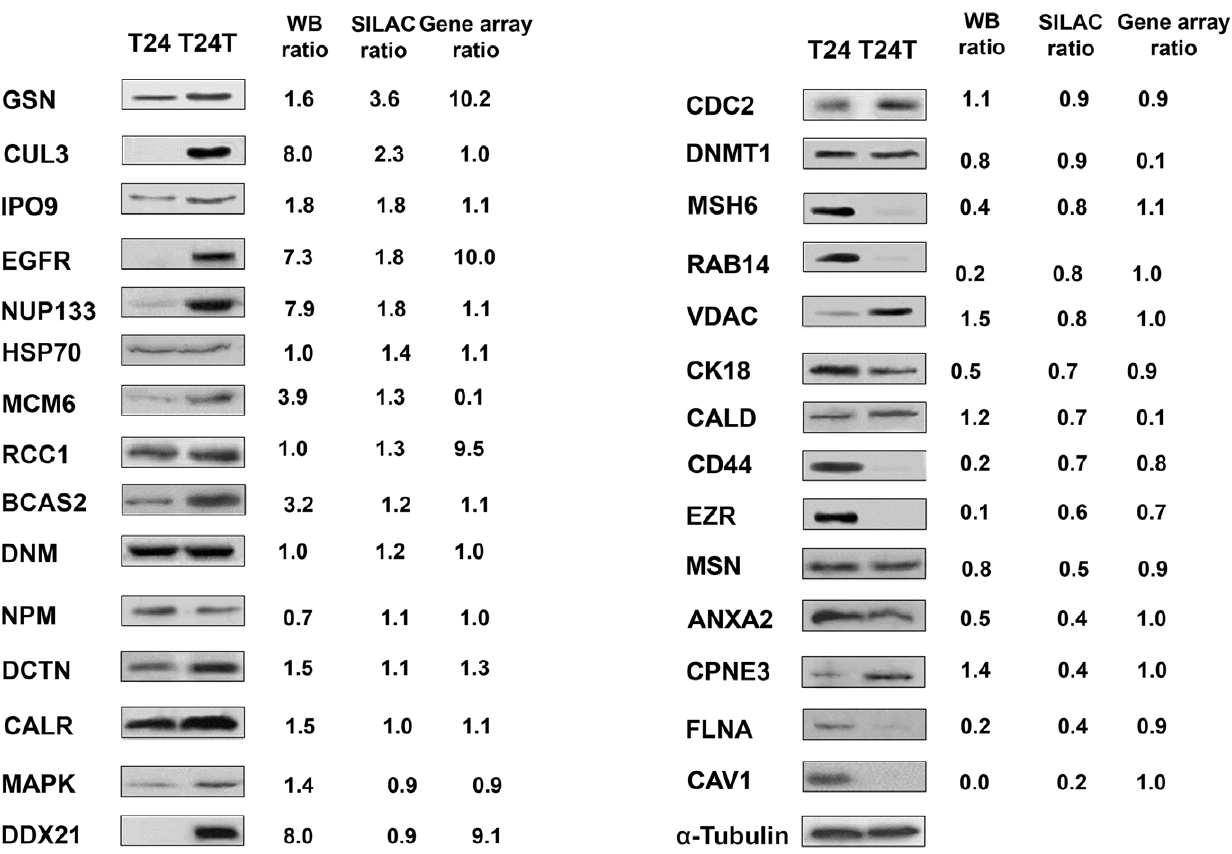
Figure 3. Verification of the expression of the proteins identified. ( A ) Validation of the SILAC results of selected proteins in immunoblots of protein extracts from the bladder cancer cells analyzed. The results validated the expression levels of proteins identified by the proteomic approach, including differentially and non-differentially expressed candidates. Antibodies displaying a single predominant band at the expected molecular weights were accepted: and a -tubulin, was used as the loading control. GSN, Gelsolin; Cul3, Cullin 3; IPO9. Importin 9; EGFR, Epidermal Growth Factor Receptor; NUP133, Nucleoporin 133; HSP70, Heat Shock Protein 70kDa; MCM6, Minichromosome Maintenance Complex Component 6; RCC1, Regulator of Chromosome Condensation 1; BCAS2, Breast Carcinoma Amplified Sequence 2; DNM, Dynamin; NPM, Nucleophosmin; DCTN, Dynactin; CALR, Calreticulin; MAPK, Mitogen-Activated Protein Kinase; DDX21, DEAD (Asp-Glu-Ala-Asp) box polypeptide 21; CDC2: Cell Division Cycle 2; DNMT1, DNA (cytosine-5)-Methyltransferase 1; MSH6, MutS Homolog 6; RAB14, GTPase Rab14; VDAC, Voltage-Dependent Anion Channel; CK18, Cytokeratin 18; CALD, Caldesmon; CD44, CD44 antigen isoform 1 precursor 2; EZR, Ezrin; MSN, Moesin; ANXA2, Annexin A2; CPNE3, Copine 3; FLNA, Filamin A; CAV1, Caveolin 1. Western Blots were scanned and analyzed using a -tubulin as normalizing